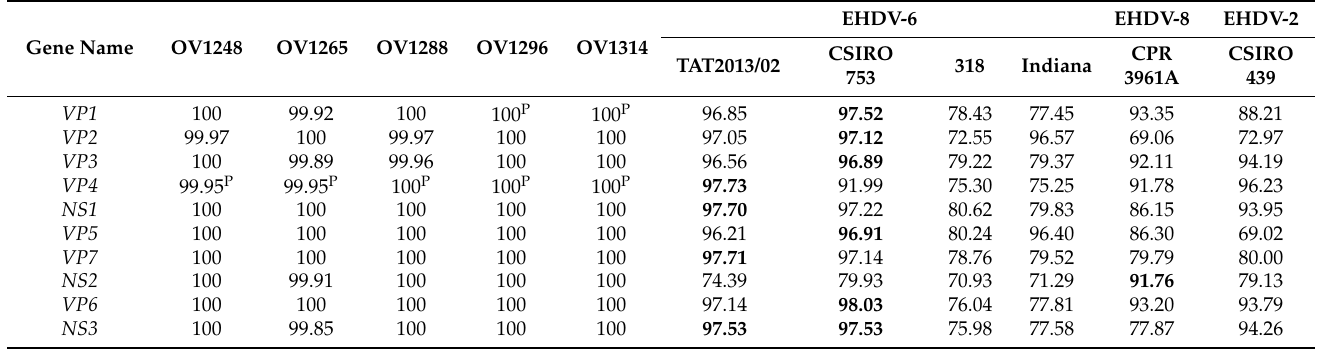
Table 4. Nucleotide identities for the coding sequences of each segment of the U.S. novel reassortant EHDV-6 strain isolated from a white-tailed deer (OV1321) compared to other EHDV-6 isolates from the same outbreak (OV1248, OV1265, OV1288, OV1296, and OV1314) and to selected EHDV-2, EHDV-6, and EHDV-8 isolates. Segments with incomplete coding sequences are indicated with the superscript P for partial. The highest nucleotide identities of EHDV-6 (OV1321) compared to selected EHDV-6 and EHDV-8 are bolded. Additional metadata for each EHDV isolate are provided in Supplemental Table